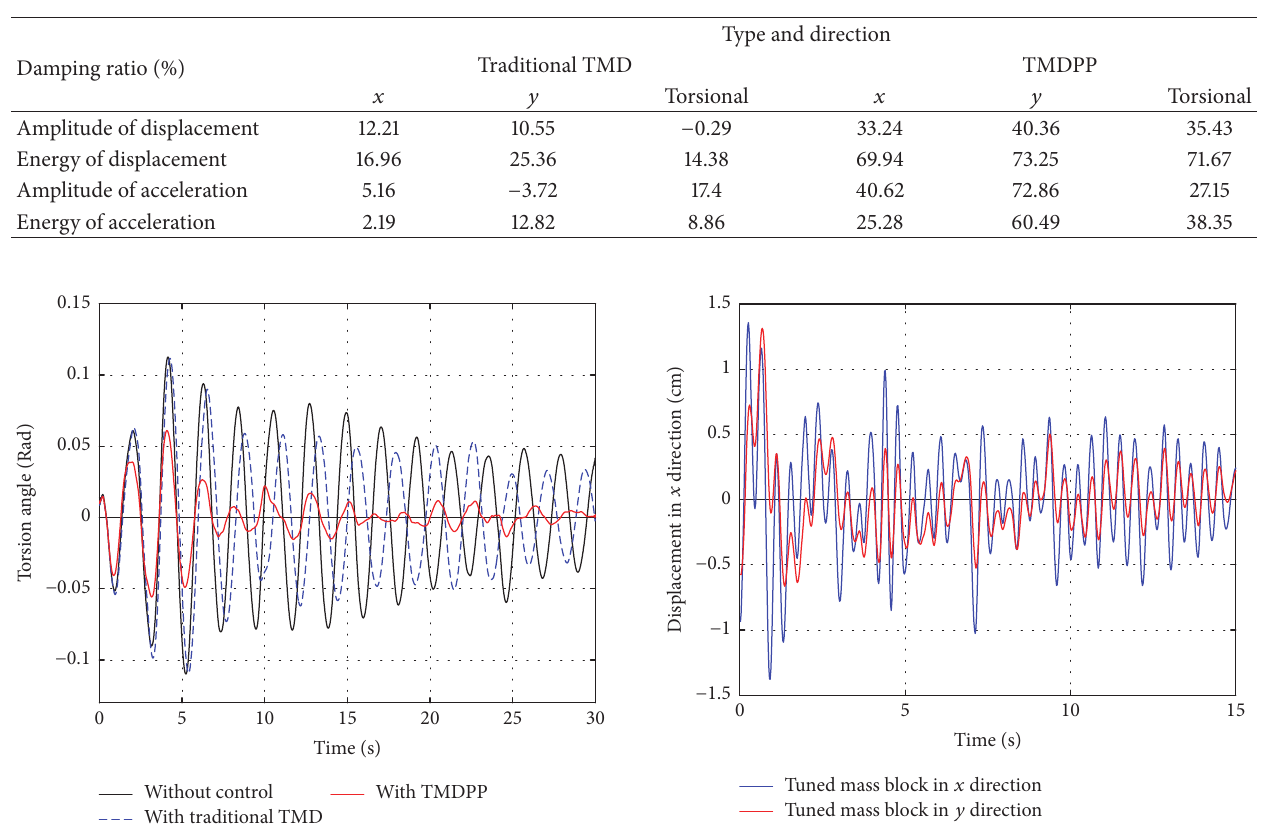
Table 3: Average damping ratio comparison of TMD and TMDPP.